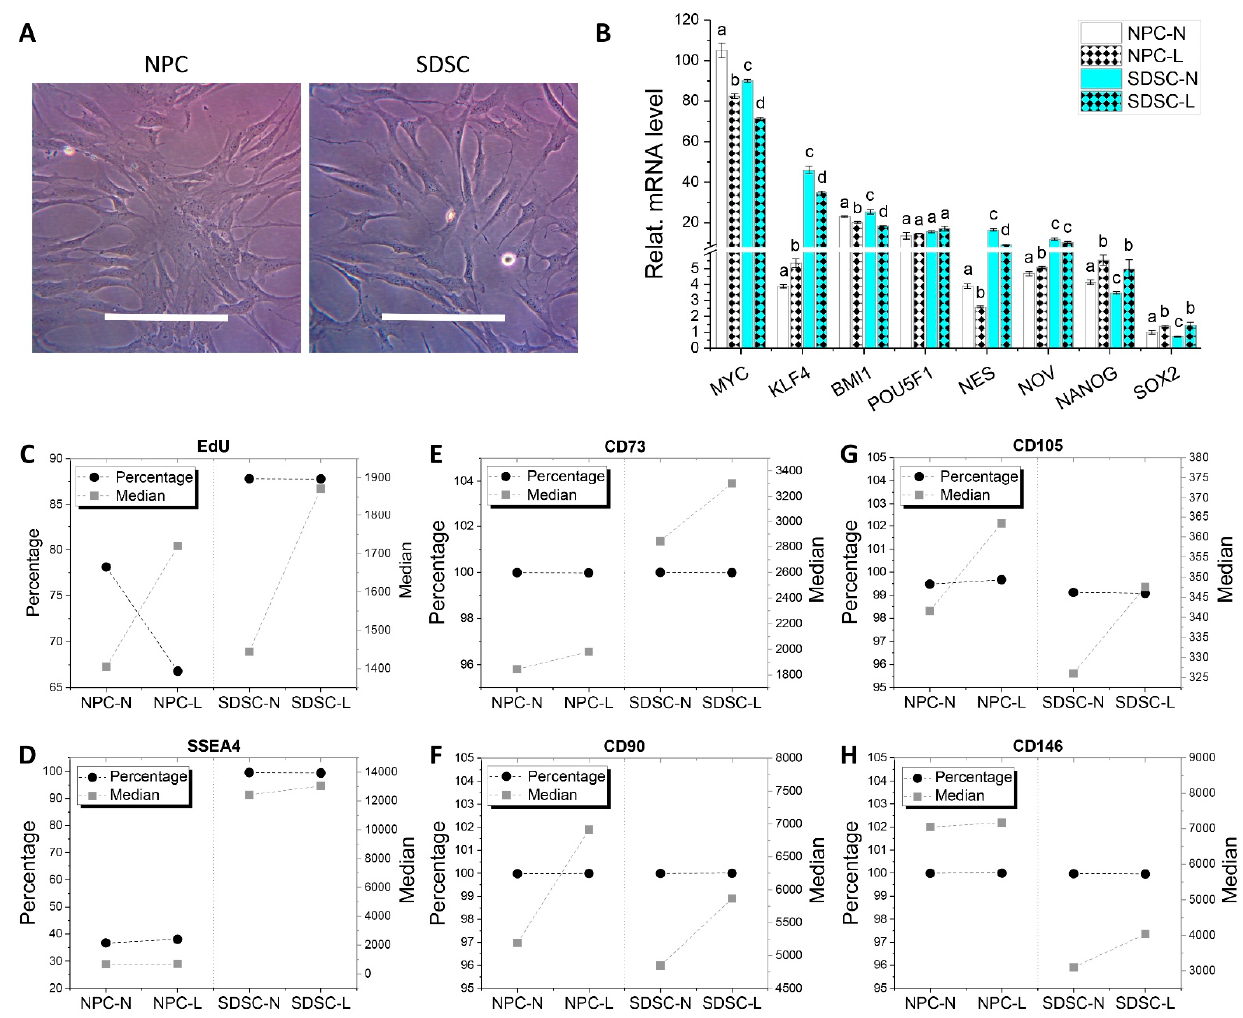
Figure 2. Evaluation of stemness gene expression, proliferation potential, and surface marker expression in fetal cells following either normoxia (N) or hypoxia (L) incubation. ( A ) Fetal NPC and SDSC cell morphology during expansion. ( B ) RT-qPCR assessed the expression of stemness genes ( MYC , KLF4 , BMI1 , POU5F1 , NES , NOV , NANOG , and SOX2 ) in both fetal cell types after hypoxia treatment, normalized against GAPDH levels as an internal control. Data ( n = 4) are represented in bar charts. Different letters indicate a statistically significant difference compared to the groups within the same gene type ( p < 0.05). Flow cytometry assessed the positive percentage and median intensity of relative EdU incorporation ( C ) and expression of MSC surface markers SSEA4 ( D ), CD73 ( E ), CD90 ( F ), CD105 ( G ), and CD146 ( H ).